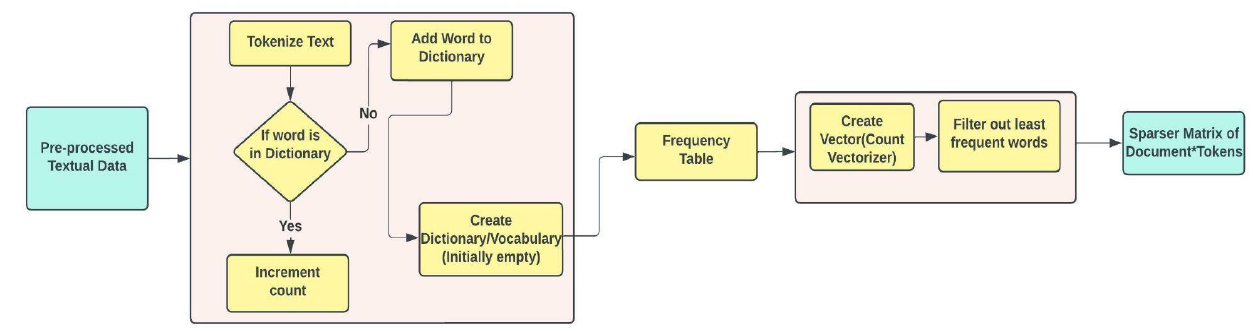
Figure 7. Bag of Words workflow to convert text data to feature